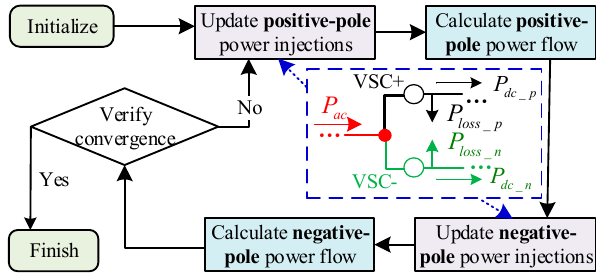
Figure 4. Bipolar power flow alternating iterative method.